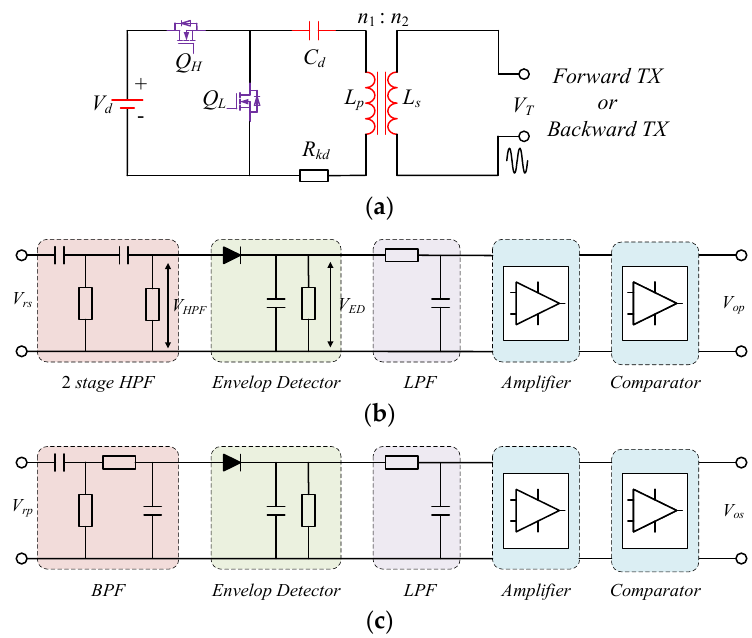
Figure 11. The schematic circuits of modulation and demodulation model. ( a ) Modulation circuit. ( b ) Forward information demodulation circuit. ( c ) Backward information demodulation circuit.